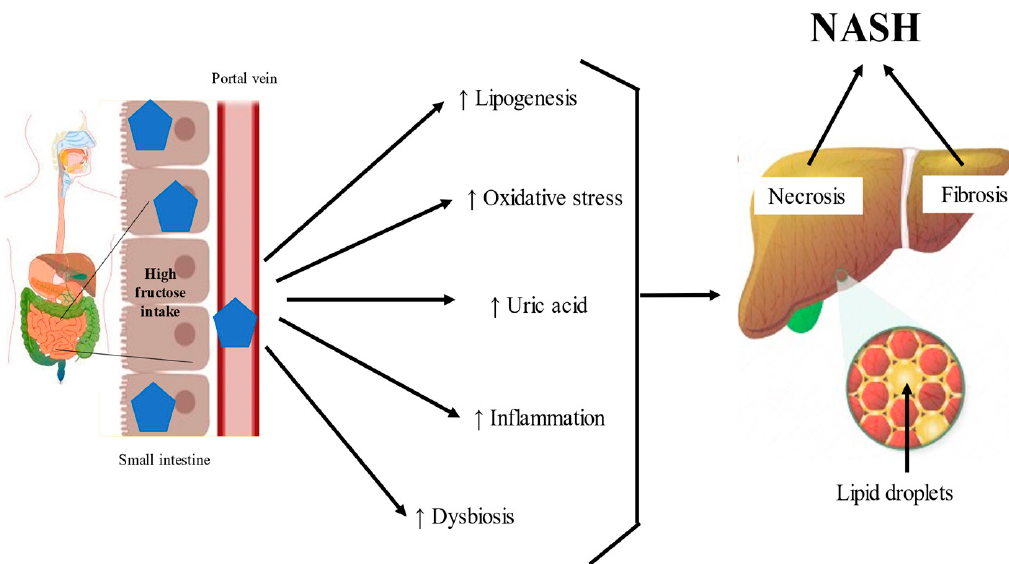
Figure 2. Fructose’s effects on the gut. Excessive fructose intake induces lipogenesis, oxidative stress, uric acid production, inflammation, and dysbiosis on the gut, which trigger necrosis and fibrosis in nonalcoholic steatohepatitis (NASH).